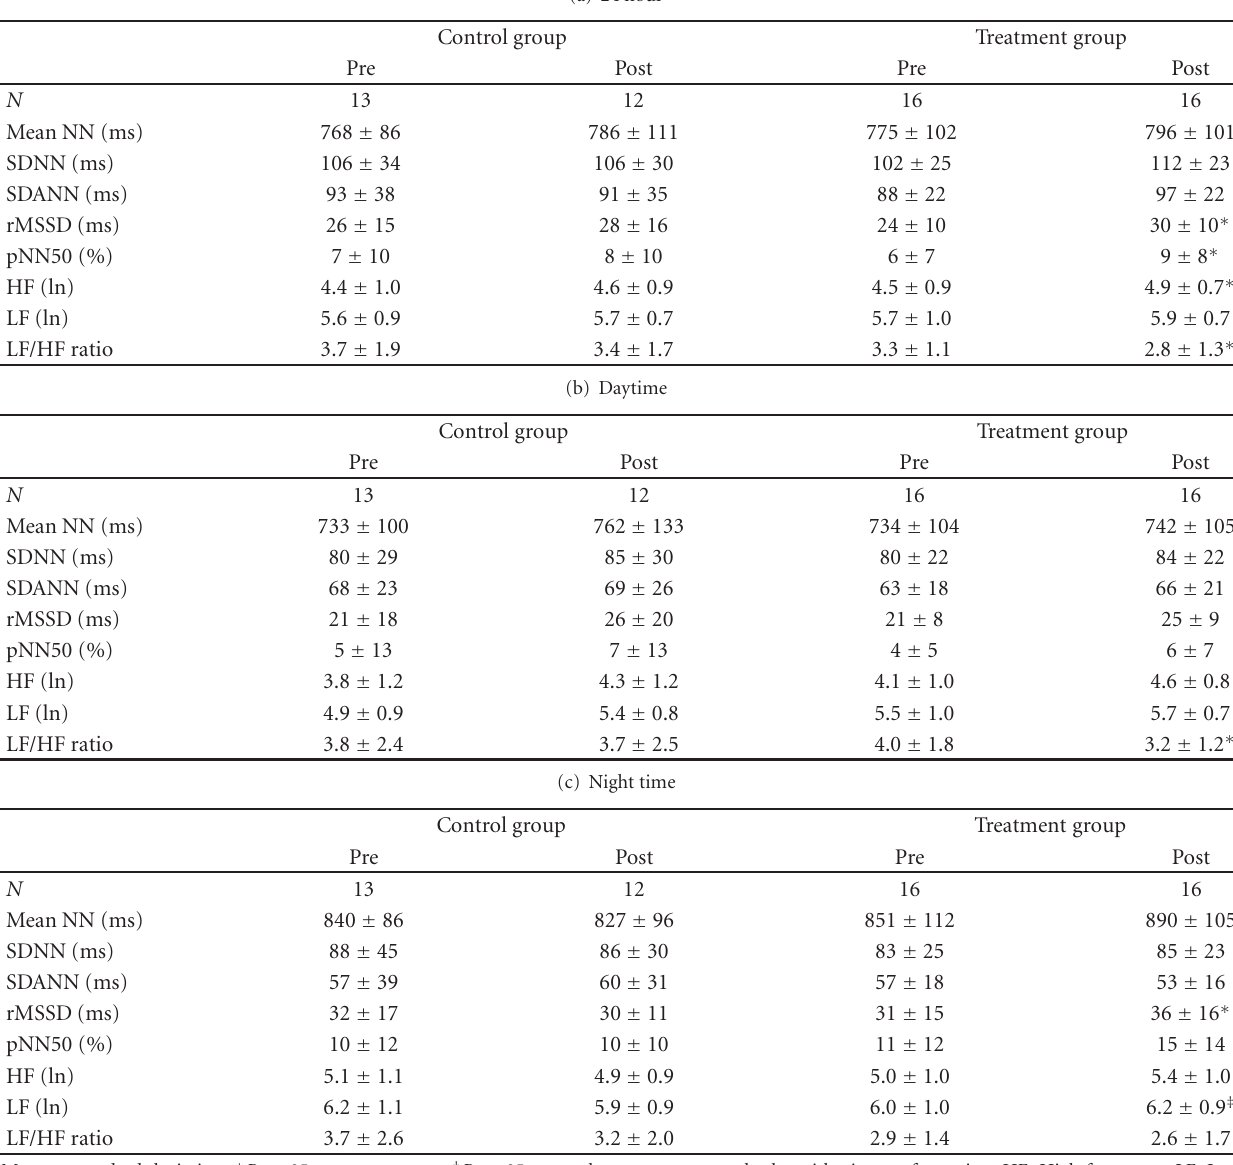
Table 2: Heart rate variability indices in severely obese subjects with type 2 diabetes before and after